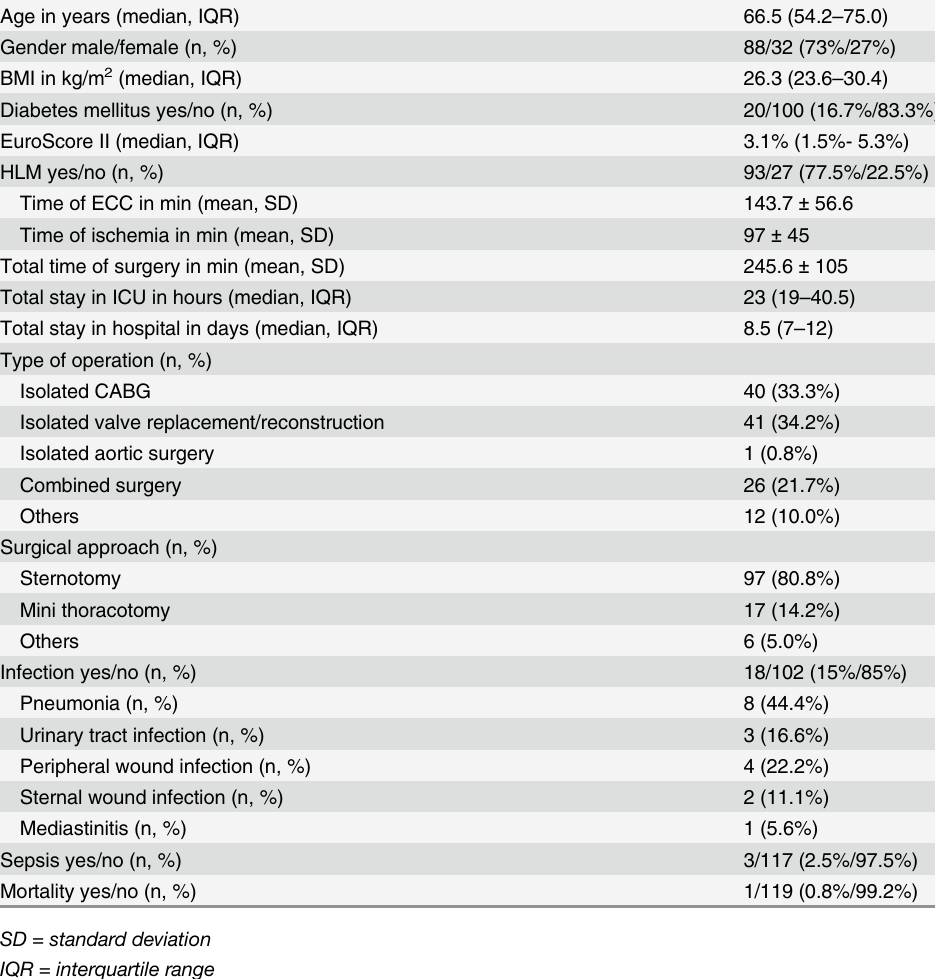
Table I. Patient- and surgery-related characteristics (n =